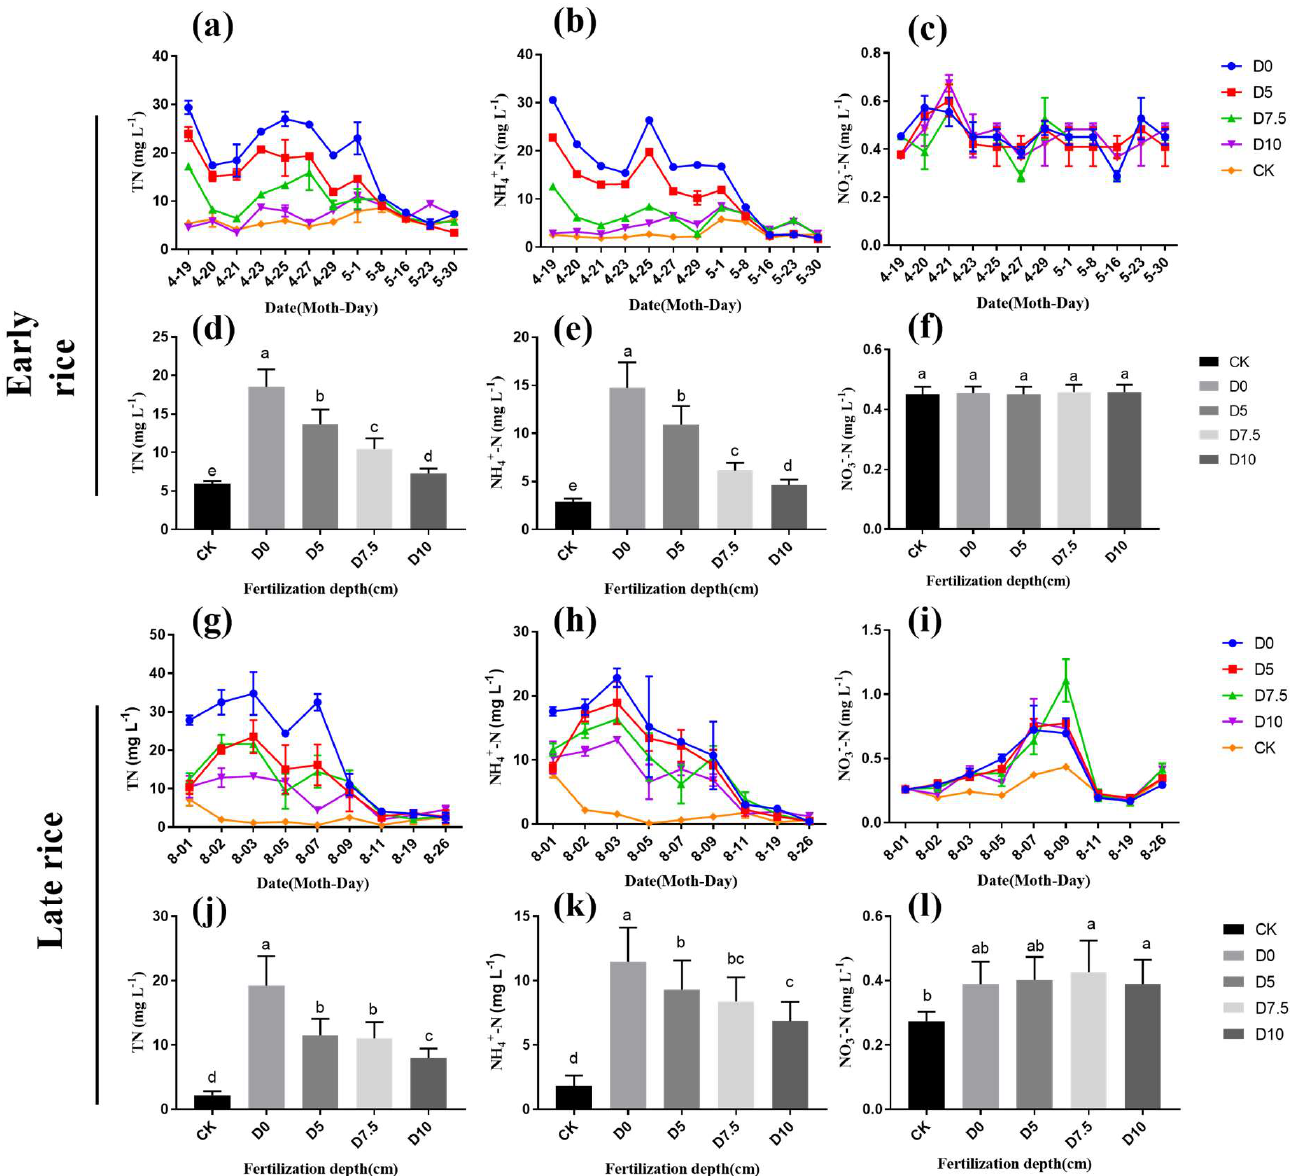
Figure 7. Variation in nitrogen concentrations of different forms in surface water under different fertilization-depth treatments. CK: no fertilizer; D0: surface spreading; D5: 5 cm side-deep fertilization; D7.5: 7.5 cm side-deep fertilization; D10: 10 cm side-deep fertilization. Different lowercase letters in the figure indicate significant difference among treatments at p = 0.05 (LSD). ( a – c ): Dynamic change of different nitrogen forms in early rice; ( d – f ): Average concentration of different nitrogen forms in early rice; ( g – i ): Dynamic change of different nitrogen forms in late rice; ( j – l ): Average concentration of different nitrogen forms in early rice.